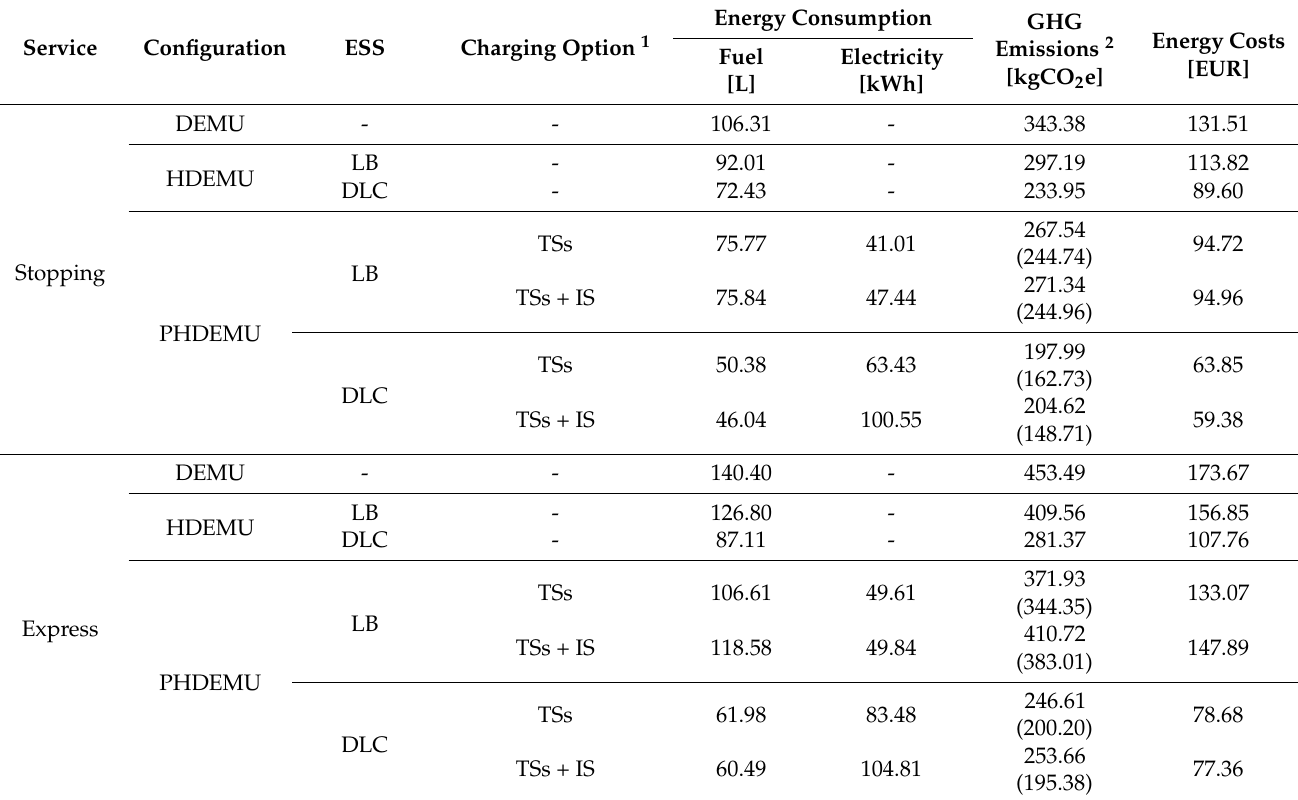
Table 4. Energy consumption, GHG emissions, and energy costs for standard, hybrid, and plug-in hybrid vehicle configurations.